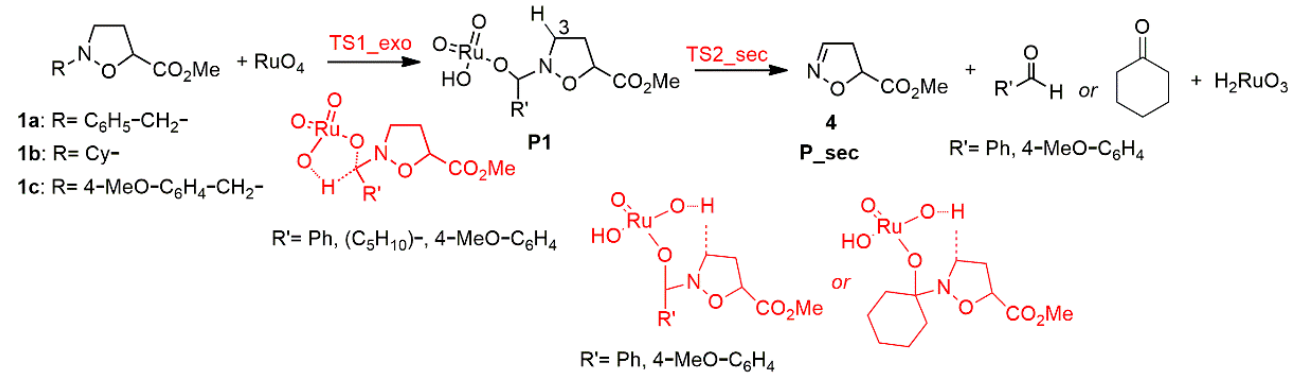
frequencies are shown as dotted lines and distances are reported in angstroms.